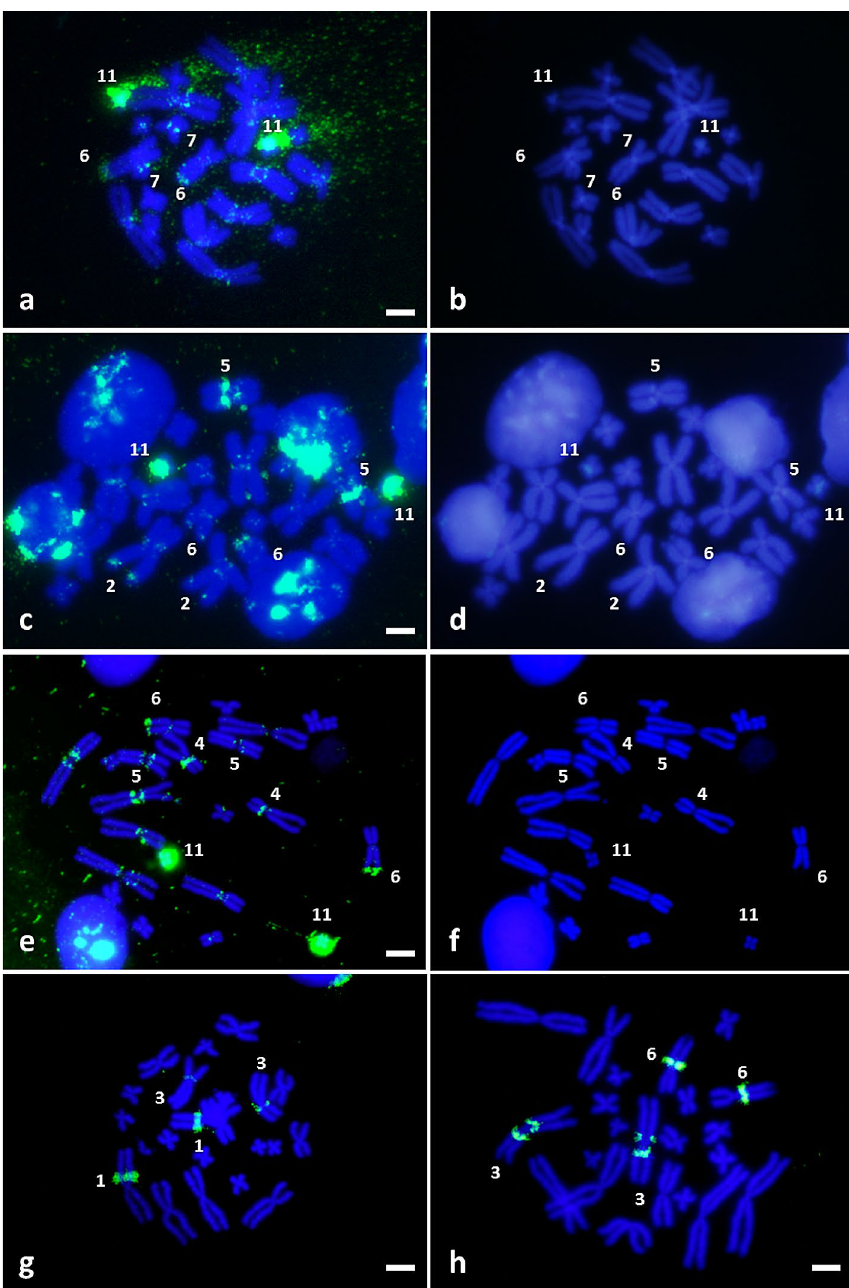
Figure 4. FISH on metaphase chromosomes from Bufo bufo ( a , b ); Bufo spinosus ( c – f ); Epidalea calamita ( g ) and Bufotes viridis ( h ) using species specific BamHI-800 sequences as a probe after two ( c ) or three ( a , e , g , h ) rounds of amplification. DAPI-stained metaphase chromosomes ( b , d , f ) corresponding to ( a , c , e ), respectively. Scale bar equivalent to 2.5